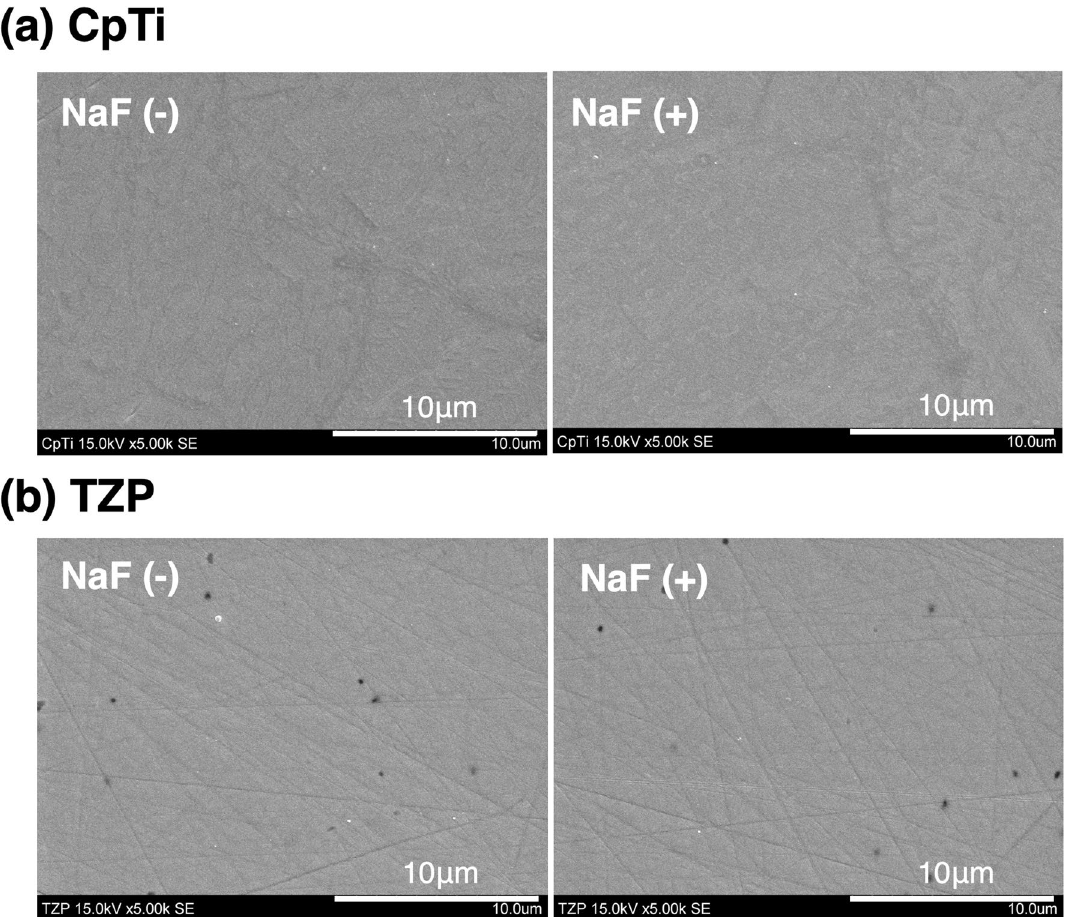
Figure 3. SEM images of the CpTi ( a ) and TZP ( b ) surfaces. In NaF (+) surfaces, SEM images are obtained after immersion in 2% NaF solution. ( a ) In CpTi, there were no changes in NaF (−) and NaF (+) surfaces, and no sign of corrosion was observed. ( b ) In TZP, there were no changes in NaF (−) and NaF (+)